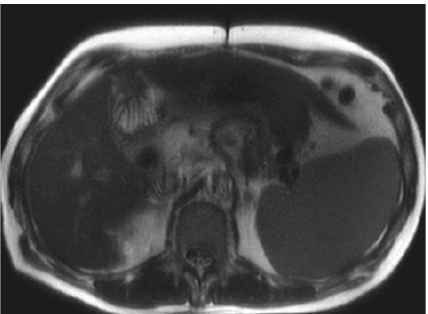
Figure 1: Magnetic resonance of abdomen. Axial view. Limited view with no major evidence of biliary ductal dilatation or filling defect in the visualized portions of the duct. The left lobe of the liver is enlarged. There is also splenomegaly.